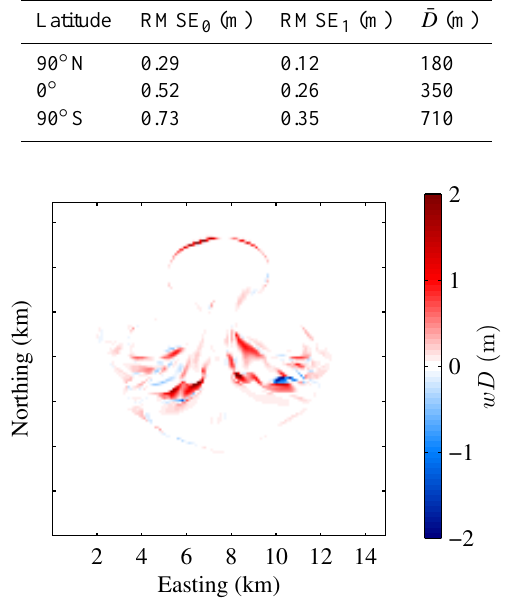
Fig. 5. Weighted displacements wD for the prediction at 0 ◦ . Here √ D = (B x 2 + B y 2 ) is the field of displacement magnitudes com- puted from the backward displacement vector field B (see Eq. 1), and w is determined according to Eq. (2).